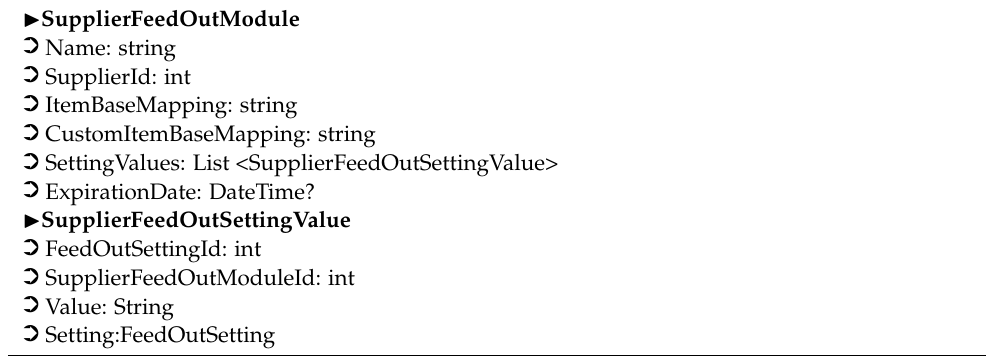
EstimateBase.cs — Estimated changes structure